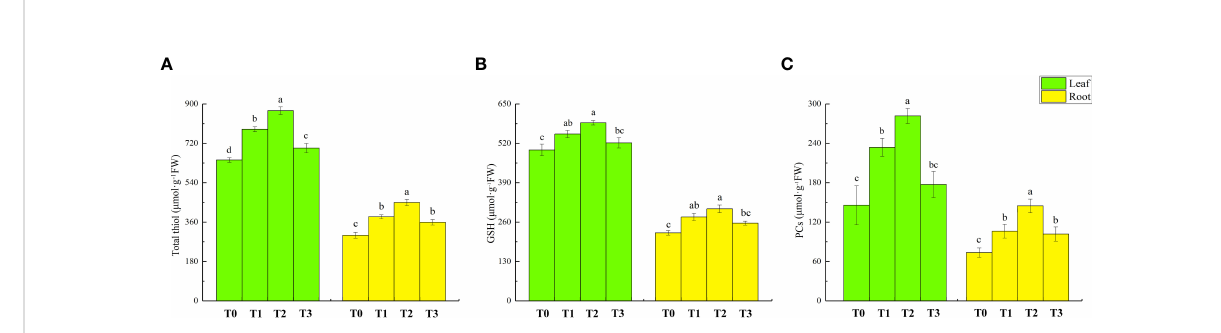
FIGURE 7 Effect of ZnONPs on total thiol content (A) , GSH content (B) and PCs content (C) and proline (Pro) content in leaves and roots of lettuce. T0, no treatment; T1, exposure to 1 mg/l Cd; T2, exposure to 1 mg/l Cd and 2.5 mg/l ZnONPs; T3, exposure to 2.5 mg/l ZnONPs. Data are shown as means ± SE of three replicates. Bars marked by different letters indicate signi fi cant differences according to Duncan ’ s test